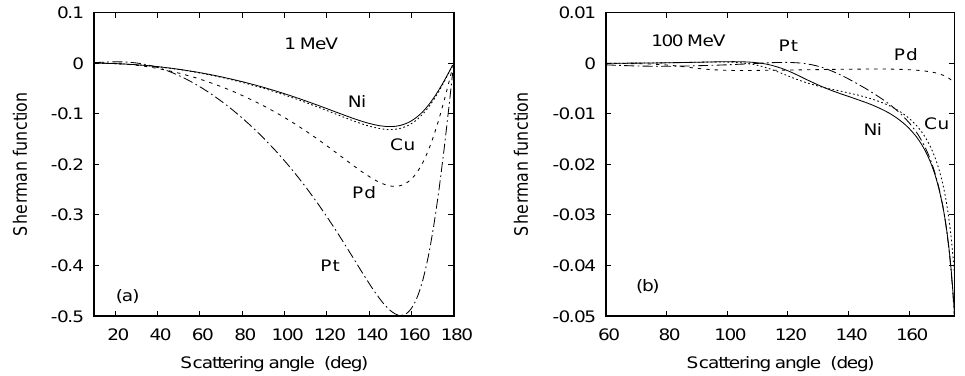
Figure 14. Angular variation of the Sherman function S for electron scattering from Ni 58 (——), Cu 63 ( · · · · · · ) , Pd 108 ( − − −− ) , and Pt 196 ( − · − · − ) at impact energies of ( a ) 1 MeV and ( b ) 100